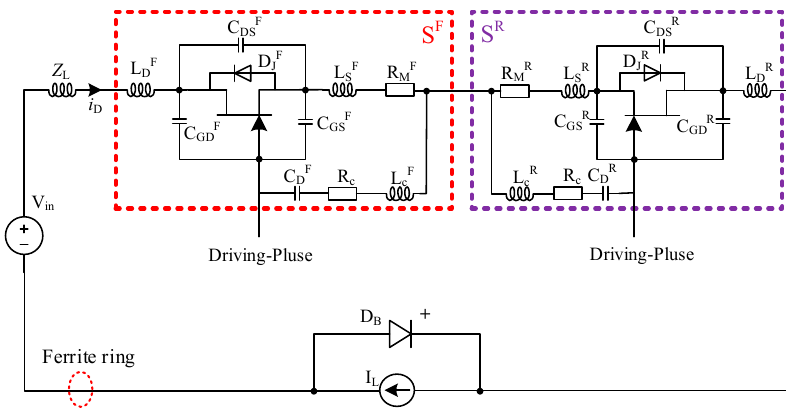
Figure 10. Dynamic schematic circuit after adding a ferrite ring.